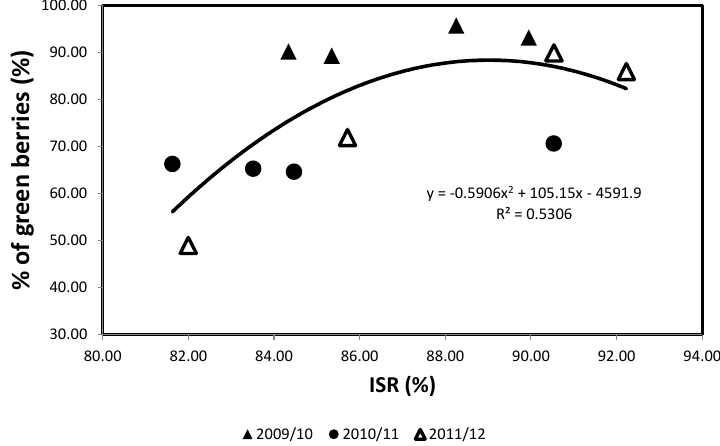
Figure 4. Percentage of green commercial berries per bunch as a function of intercepted solar radiation (ISR, %) in the different experimental growing